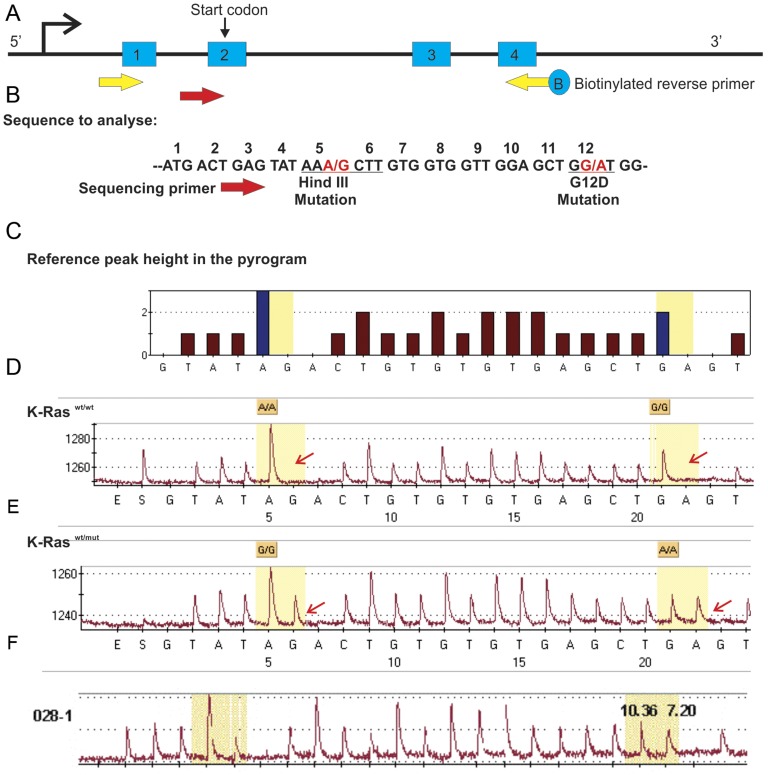
K-Ras2G12D mutation analysis.(A) Diagrammatic representation of The PCR strategy for amplifying K-Ras2 cDNA. (B) K-Ras2 sequence showing location of the mutations and the pyrosequencing primers relative positions. (C) The program’s reference peaks showing the dispensation order and sequence. (D) A pyrogram of wild type K-Ras2 allele showing no mutation, (E) one mutant allele in a tumour cell line showing the presence of mutant as well as wild type alleles and (F) the mutant allele in a micro dissected primary tumour. In Figure E, the difference in relative intensity between the normal and mutant allele specific nucleotide base indicates presence of normal cells in the tumour.